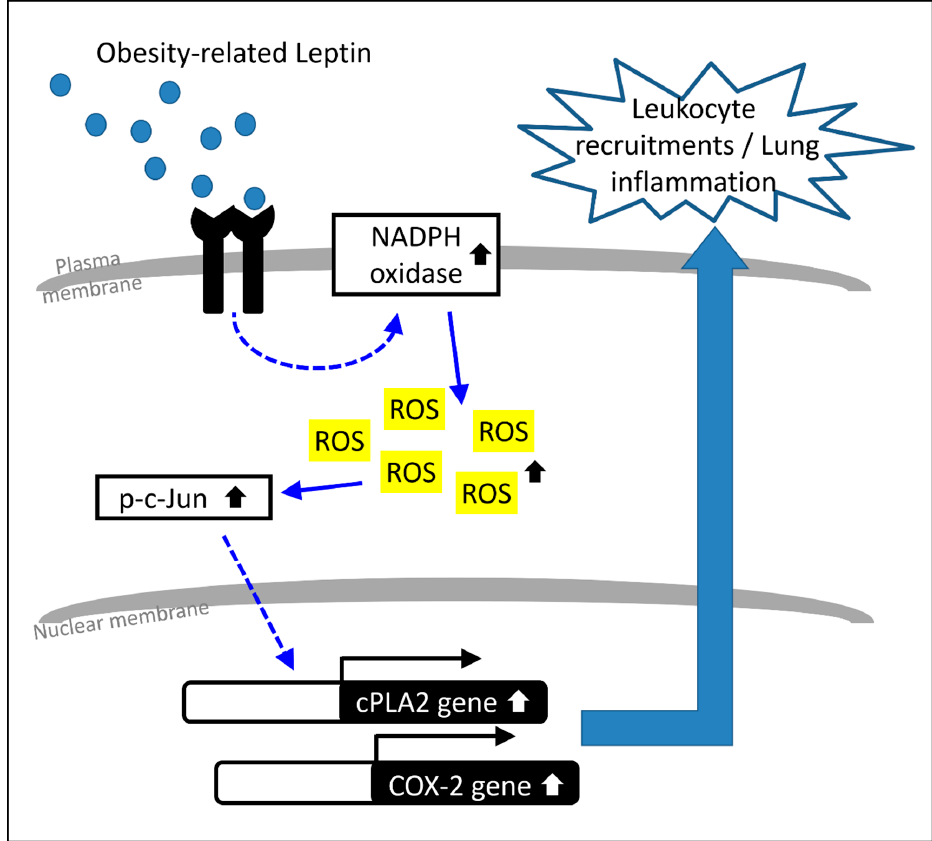
Figure 6. Leptin increased the expression of cPLA2/COX-2 together with accumulation of leukocytes via the NADPH oxidase/ROS/AP-1 pathway. According to the results and literature surveys, leptin promoted the activation of NADPH oxidase, resulting in the accumulation of intracellular ROS. The increase of oxidative stress contributed to the phosphorylation of c-Jun in leptin-stimulated lung tissue. In response to the leptin stimulation, activated AP-1 upregulated the expression of cPLA2 and COX-2 genes, contributing to leukocyte recruitment and lung inflammation. The solid arrows represented a step in an activating pathway. Dashed arrows represented the uncertain mechanism that needs to be evaluated in the